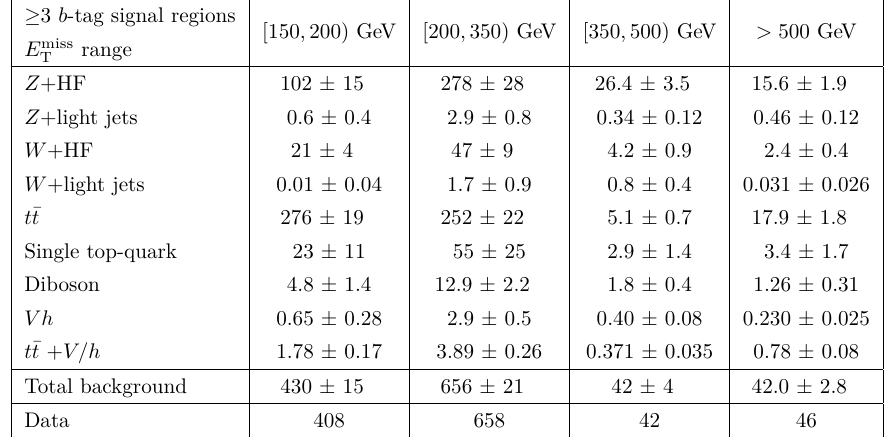
Table 5. Background yields in comparison with data in the ≥ 3 b -tag signal regions for different E miss ranges after a background-only fit to data. Statistical and systematic uncertainties are re- T ported